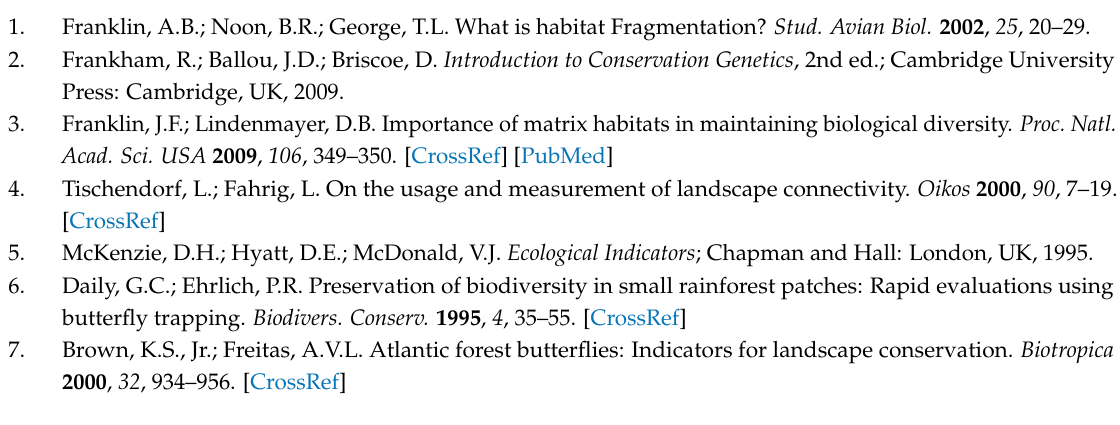
Figure S1: Distribution map for the three subspecies of Eunica tatila . Blue circle ( Eunica tatila tatilista ), yellow circle ( Eunica tatila tatila ), and green circle ( Eunica tatila bellaria ). According to Reference [37], using ArcView GIS 3.2., Figure S2: Relation between genetic diversity parameters, H e (blue) and PPL (red), and forest patch size. A: All patches, B: enlargement of zone between 0–100 km 2 . Results of Spearman correlation ( r and p ), Figure S3: Population structure provided by STRUCTURE analysis ( K = 2) for Eunica tatila . Each individual is represented by a single vertical line broken into K segments whose length is proportional to the estimate membership probability ( q i ) in the K